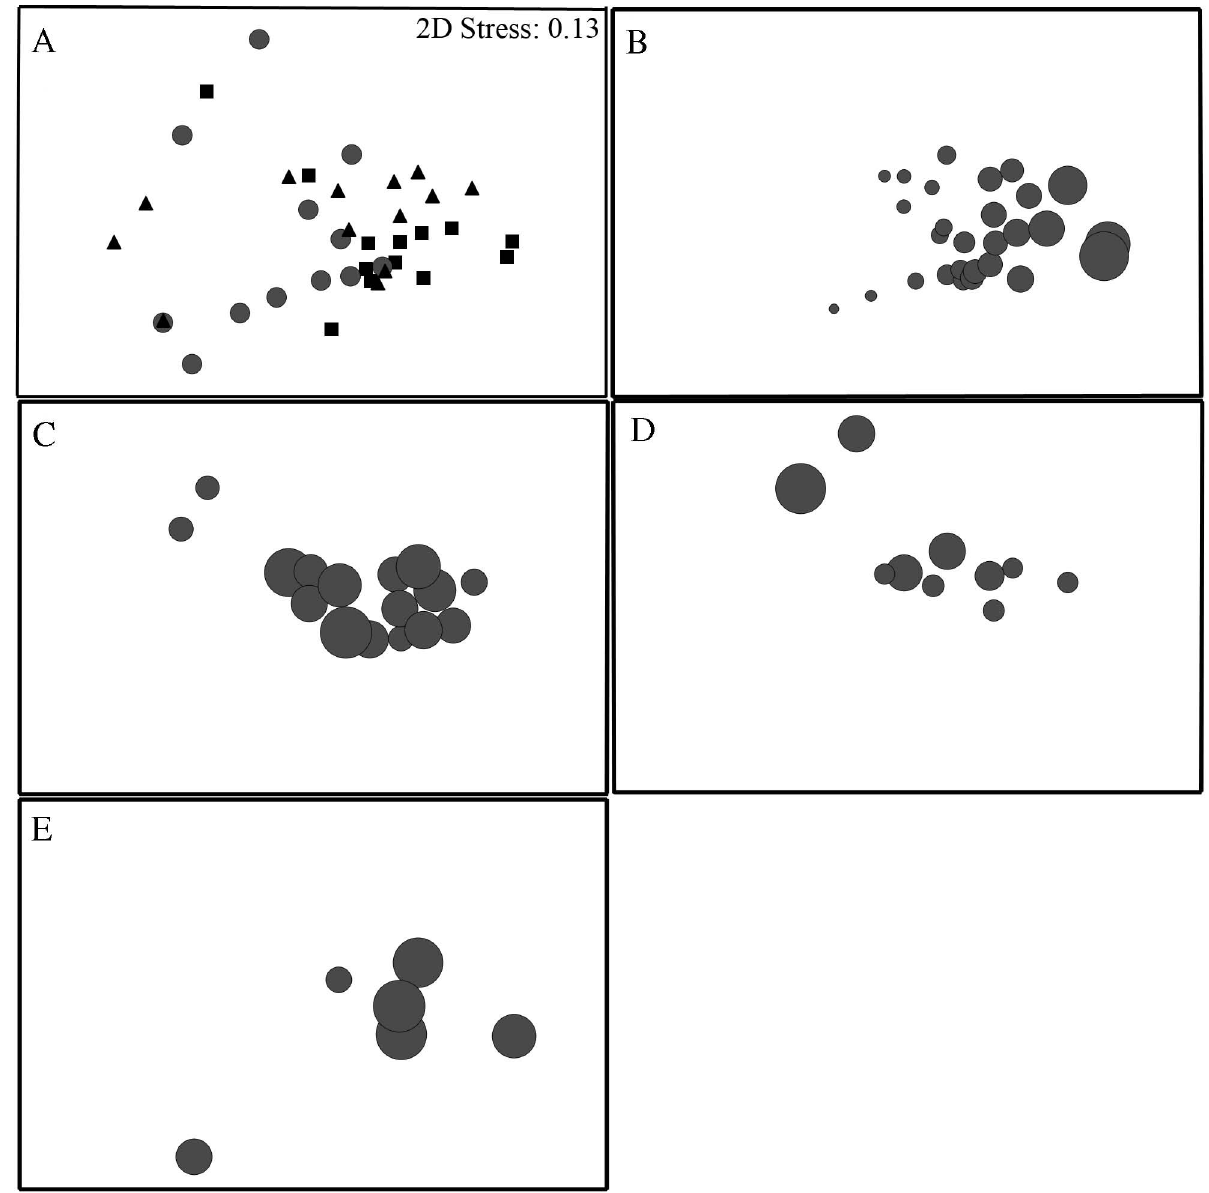
Fig . 2. – nMDS of decapod assemblage according to bed density. A, l density 60- 100 ind m –2 , ▲ density 100-200 ind m –2 , n density >200 ind m –2 . B-E, bubble plot with abundance of Mithraculus forceps , Pilumnus caribaeus, Cuapetes americanus and Petrolisthes galathinus,